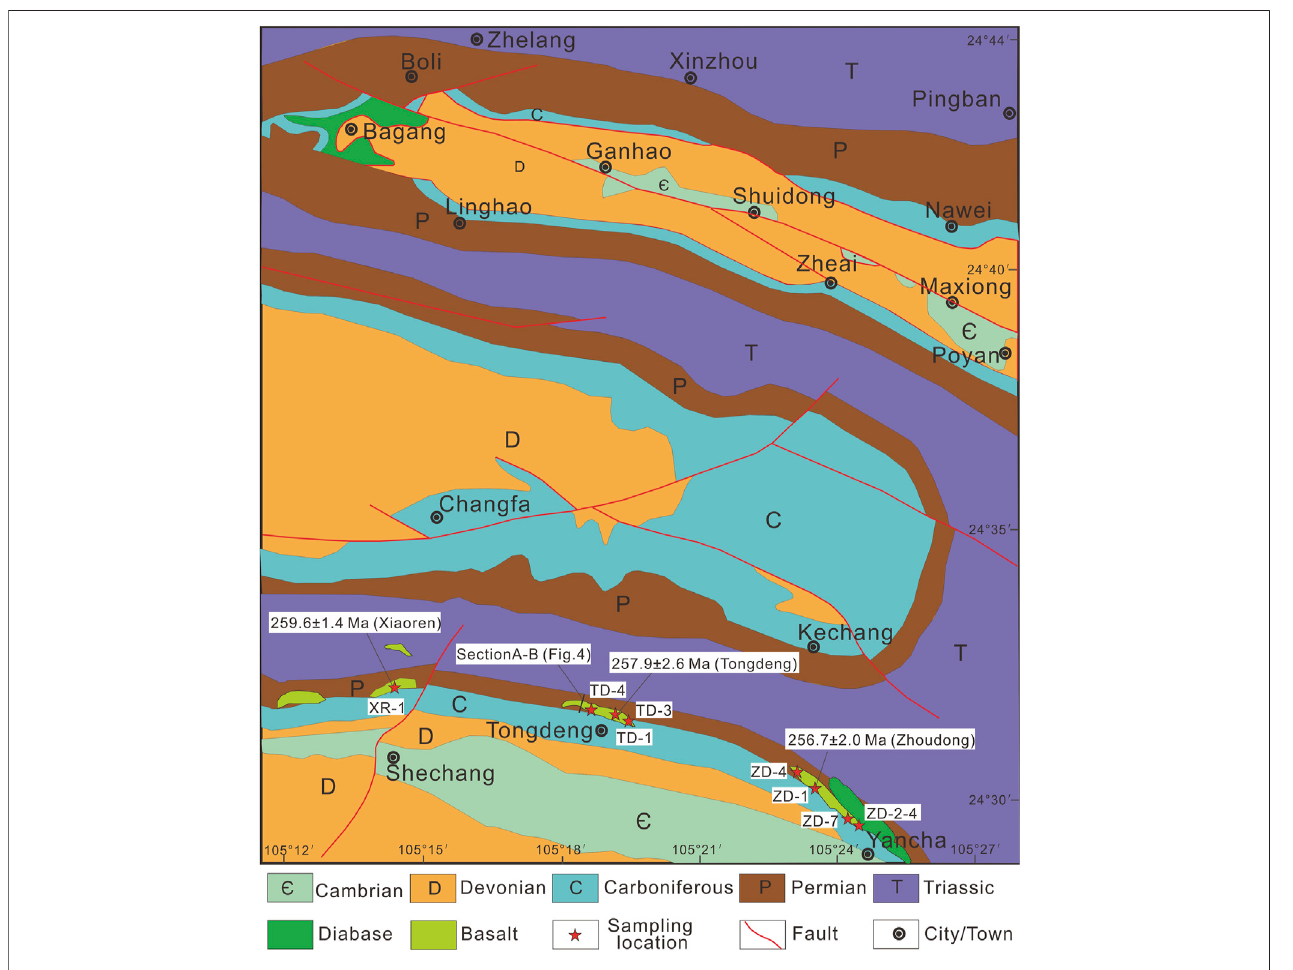
FIGURE 2 | Geologic sketch map of the Longlin area in western